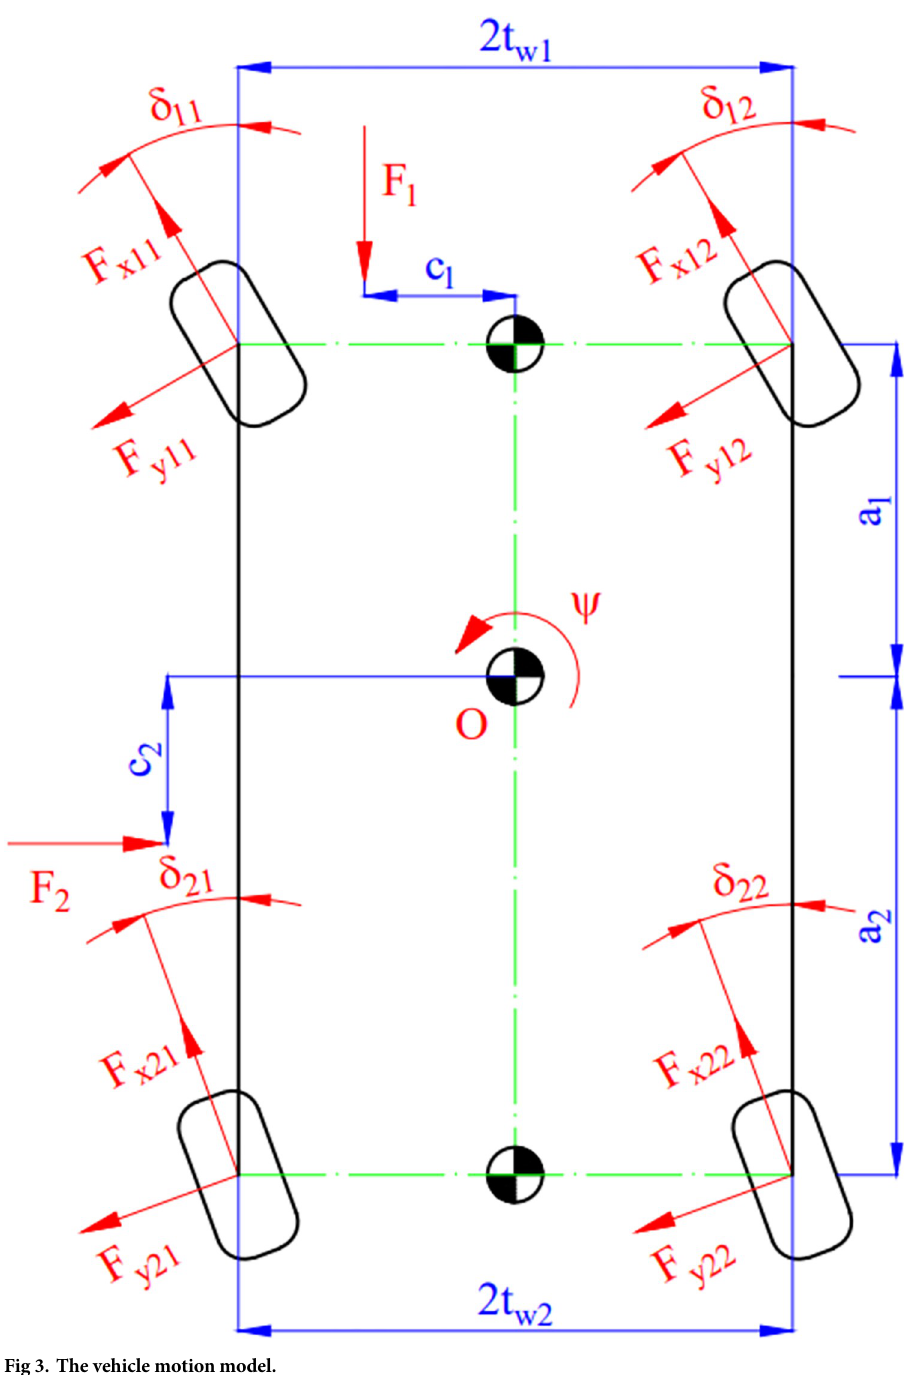
Fig 3. The vehicle motion